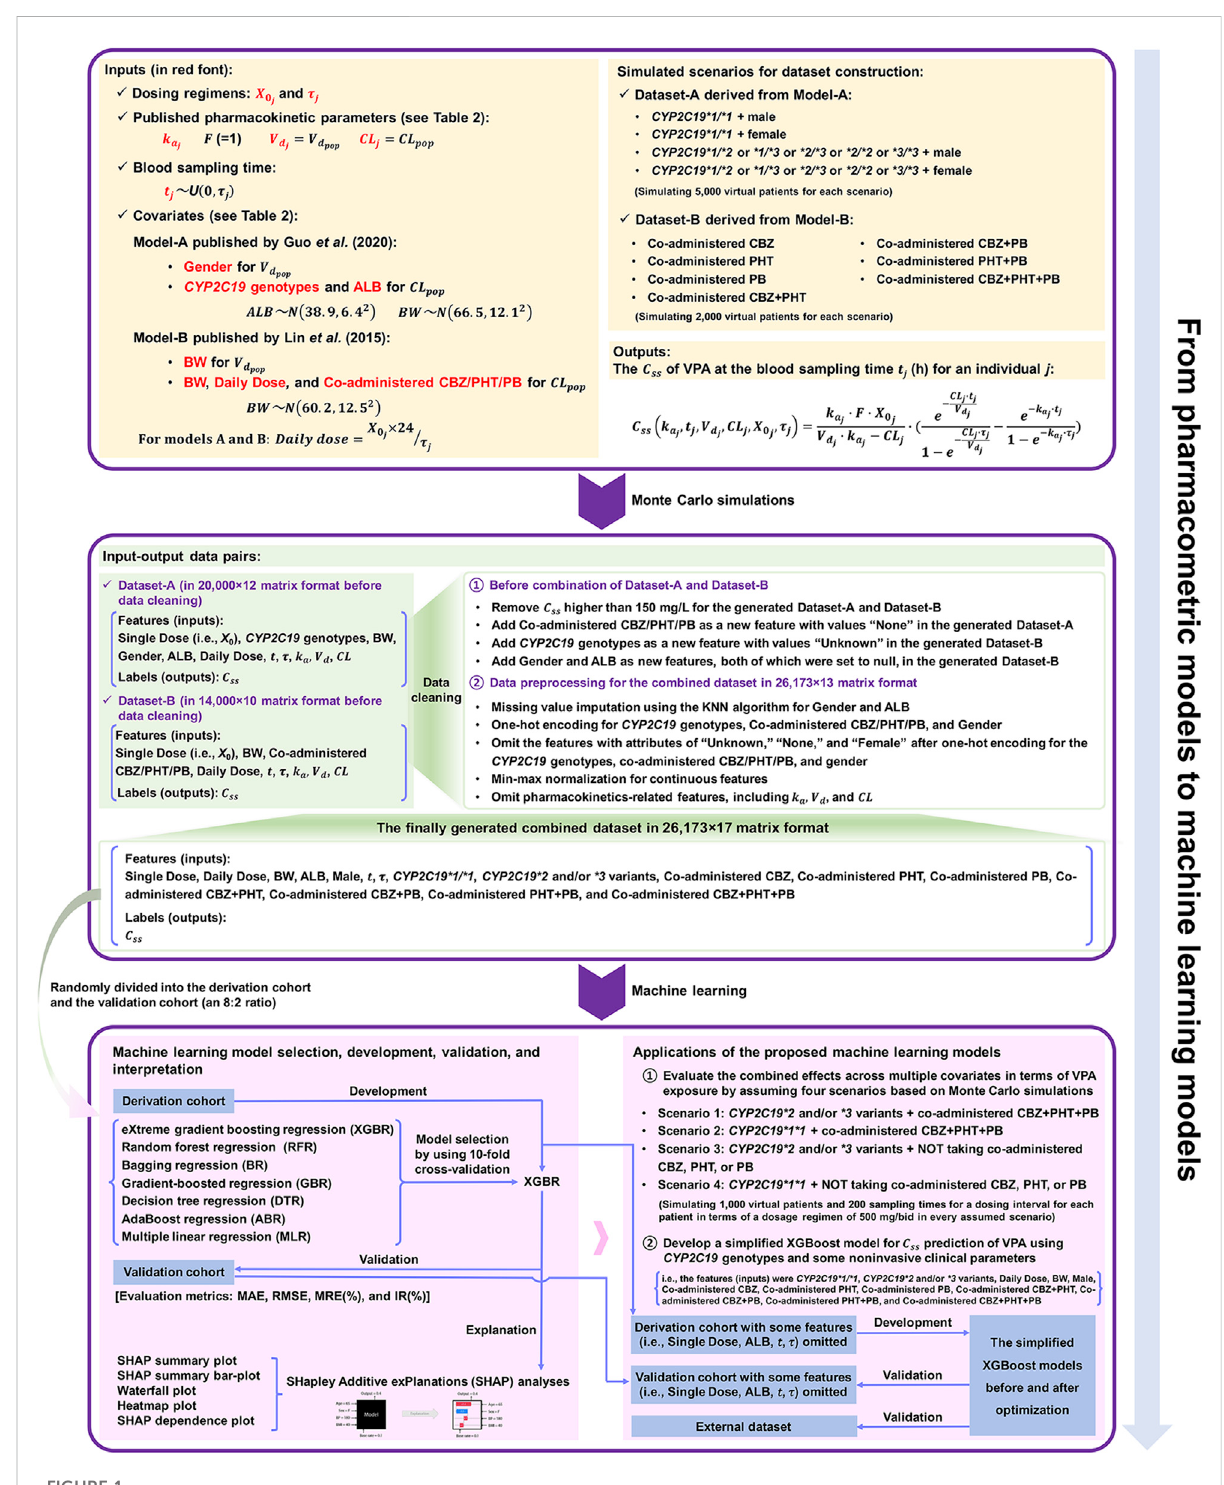
FIGURE 1 Thework fl owfrompharmacometricsmodelstomachinelearning(ML)modelsmainlyinvolvesthreeparts:1)dataacquirementfrompublished pharmacokinetic studies, 2) the construction of the combined dataset via Monte Carlo (MC) simulation and a series of data cleaning process, and 3) ML-based predictive modelling based on the fi nally generated combined